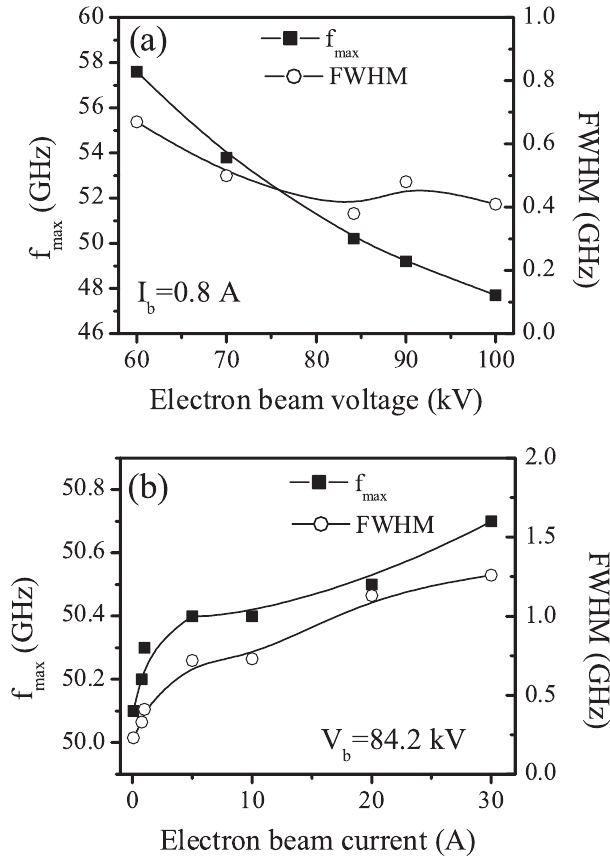
FIG. 2. Frequency of maximum saturated power and FWHM versus electron-beam accelerating voltage for I and versus electron-beam current for V are for